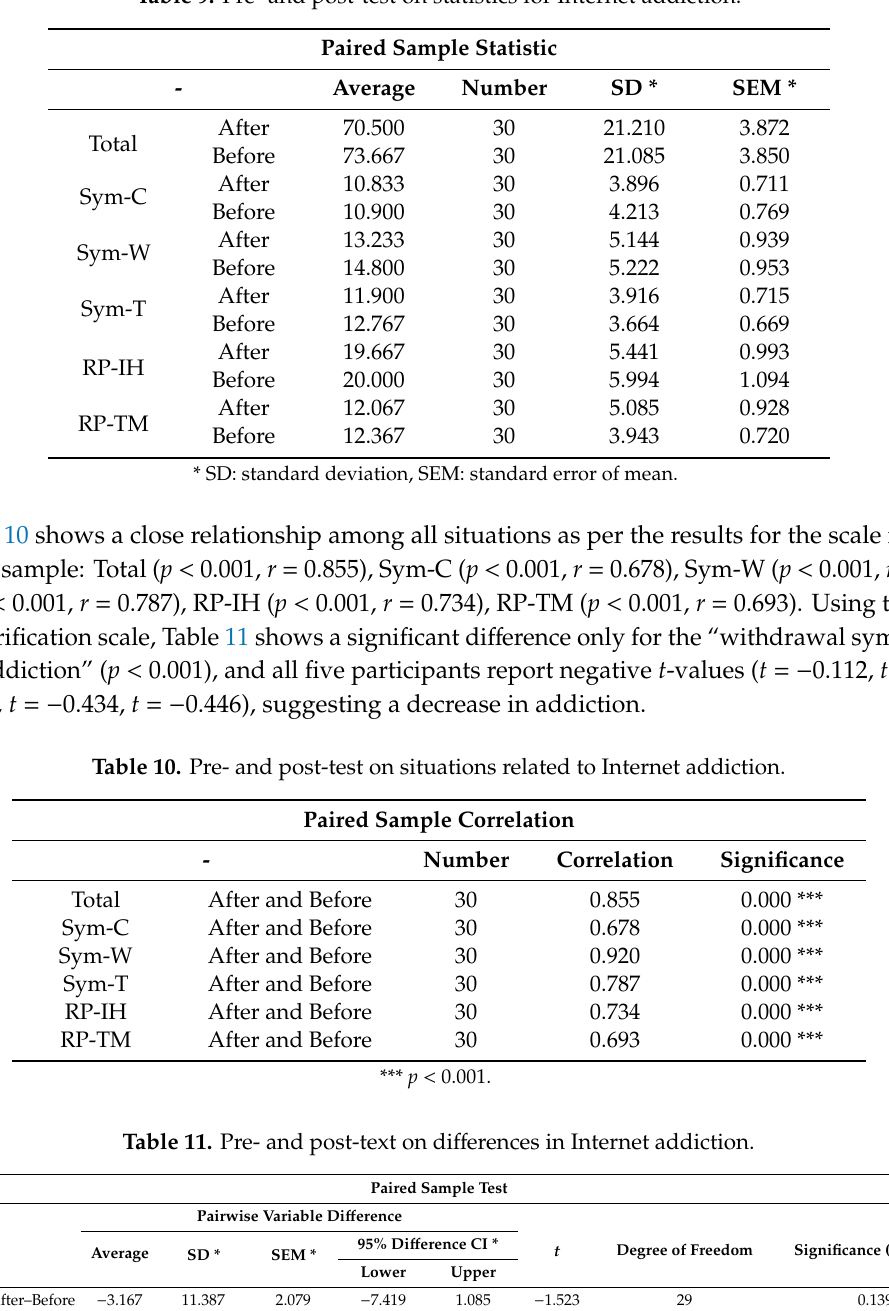
Table 9. Pre- and post-test on statistics for Internet addiction.